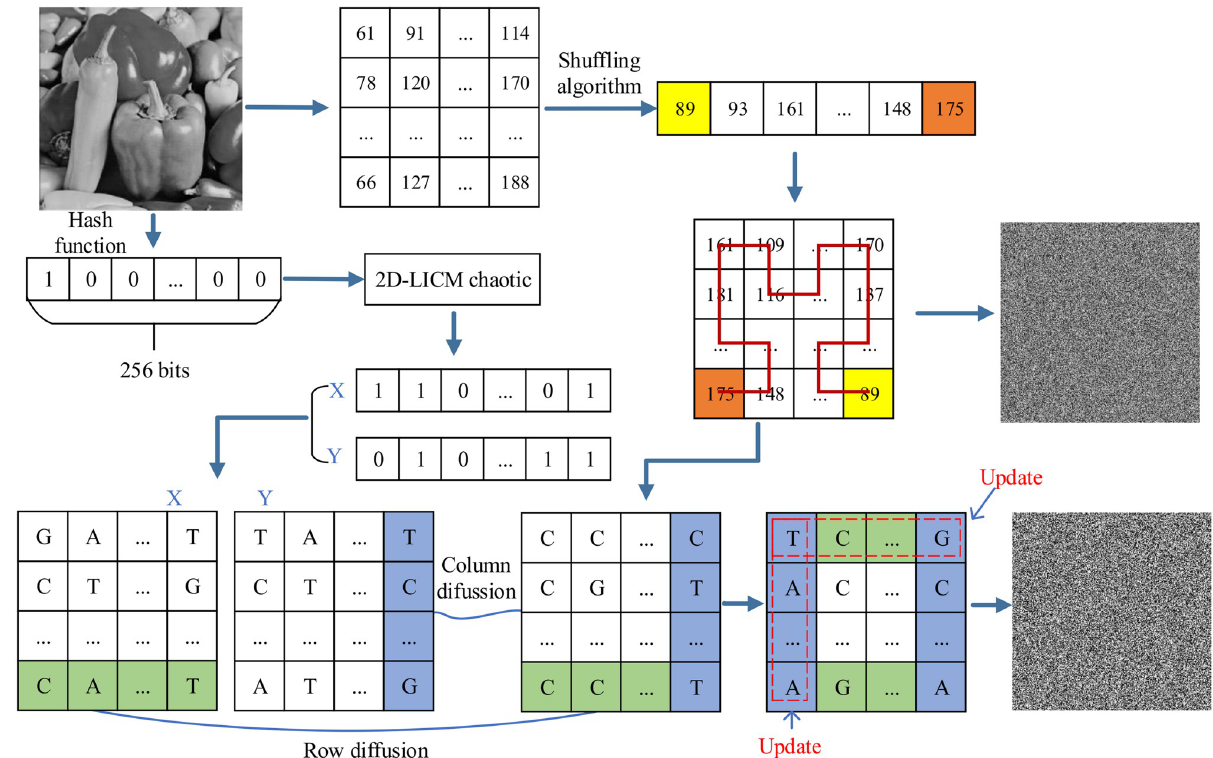
Fig 8. Flowchart of Peppers encryption step (size 256 x